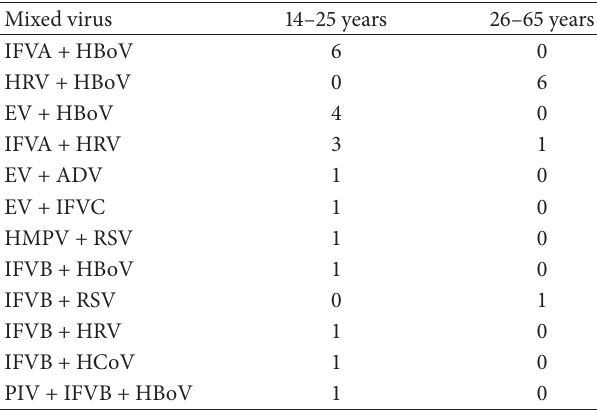
Table 3: Codetection of respiratory viruses in adults with acute respiratory tract